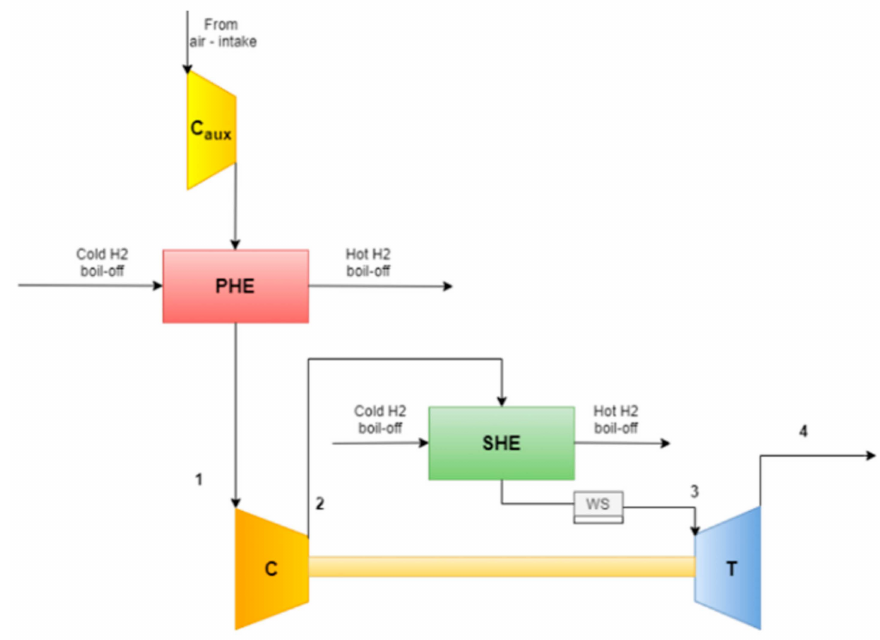
Figure 11. Cold air unit architecture [4].